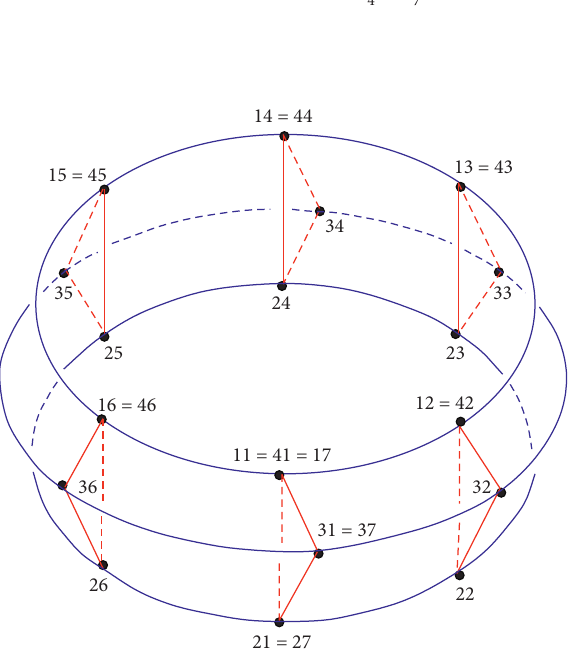
Figure 7: First fold of P